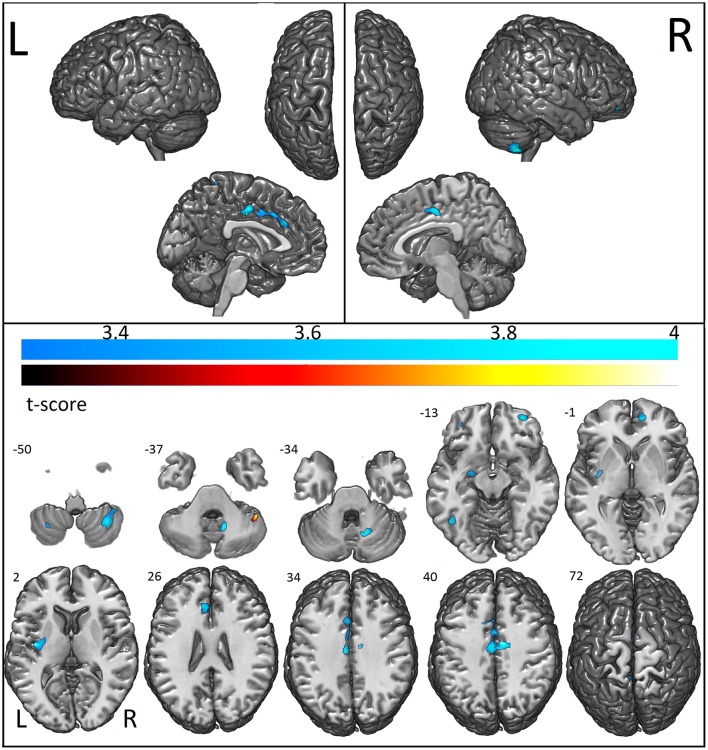
Areas with decreased (cool colormap) and increased (hot colormap) cortical voxel-based morphometry in patients when compared to controls. In shades of blue (cool colormap), the most significant regions with decreased gray matter (voxel-based morphometry, two sample t-test, p < 0.001, cluster with at least 30 voxels) in patients compared to controls. In the hot colormap (black to yellow), regions of increased gray matter (voxel-based morphometry, two sample t-test p < 0.001 clusters with at least 30 voxels).